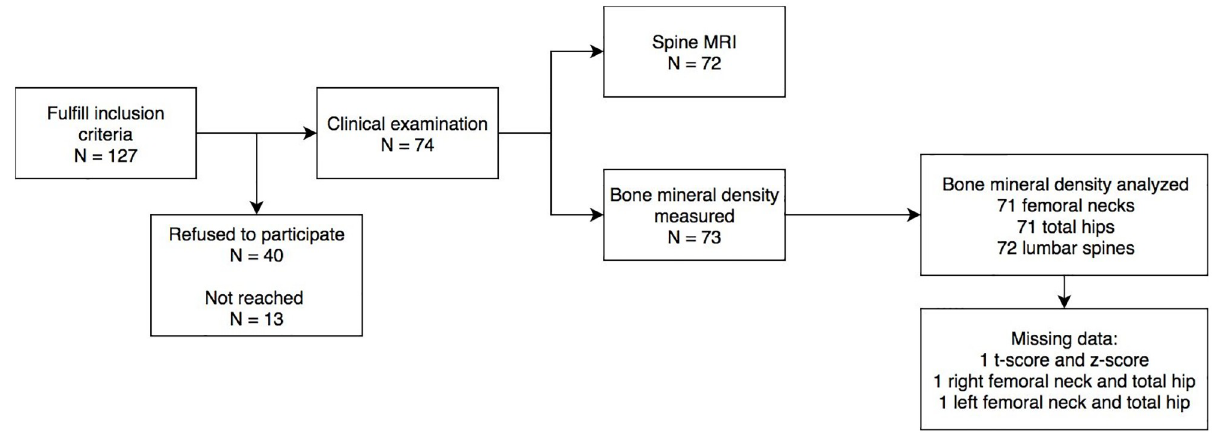
Fig 1. Flowchart of the study